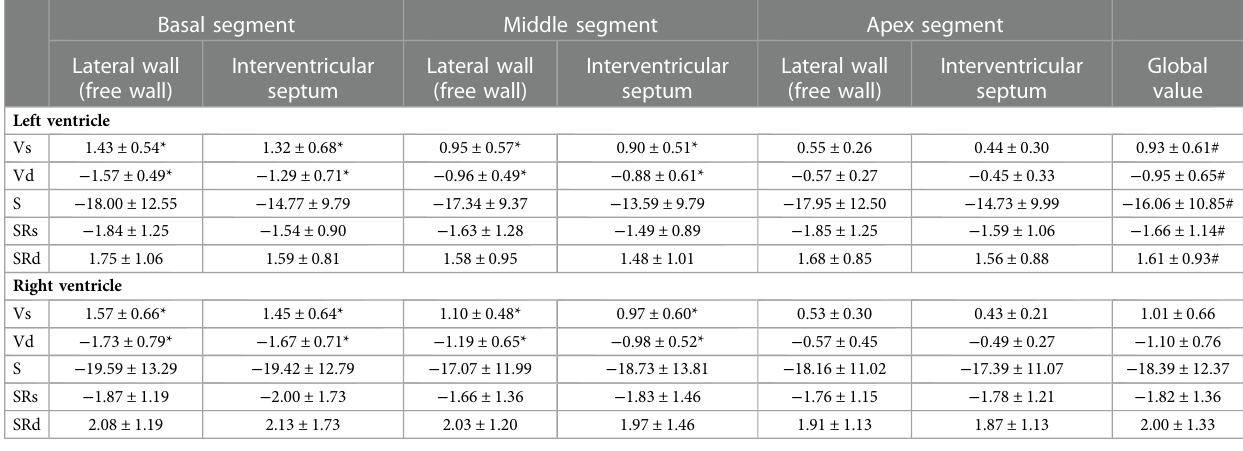
The r between the global diastolic peak velocity and the gestational age was 0.557, and the regression equation was TABLE 1 Systolic and diastolic global velocity, strain and strain rate of left and right ventricular myocardium at six segments. Basal